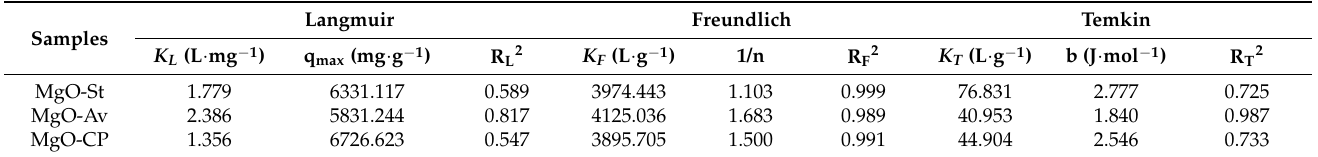
Table 4. Comparison of copper’s adsorption capacities (mg· g − 1 ) using magnesium oxide as adsorbent.